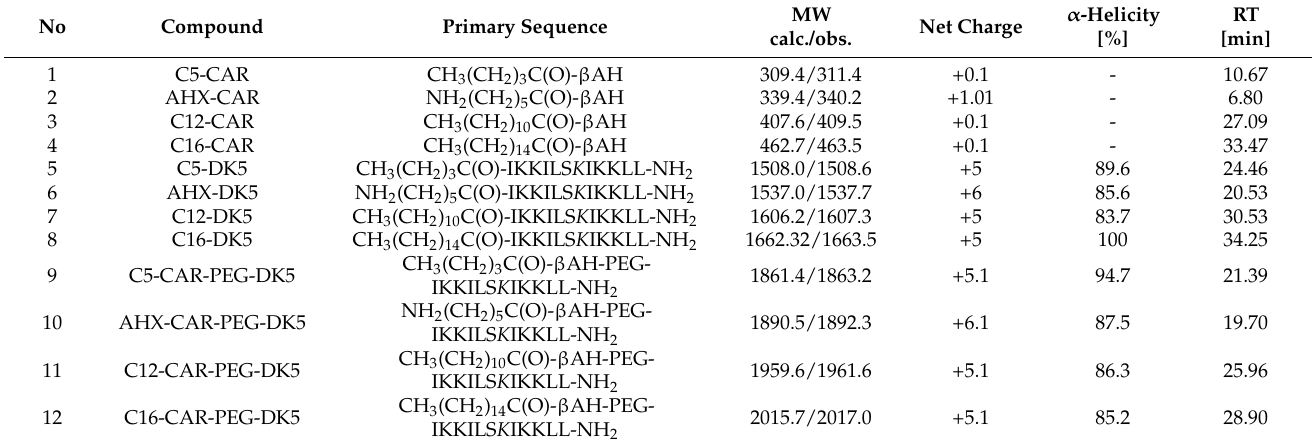
Table 1. Primary structures of the compounds with their basic physicochemical